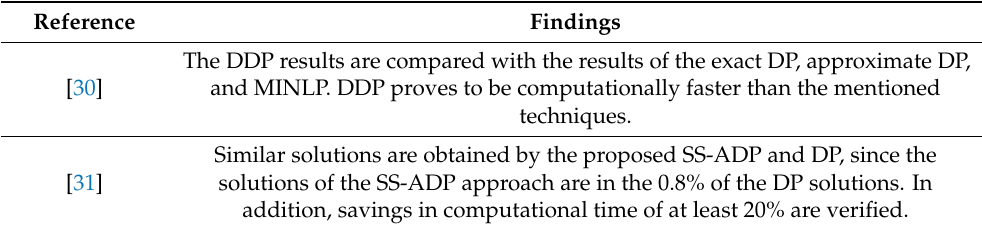
Table 10. Findings of selected papers associated with dynamic